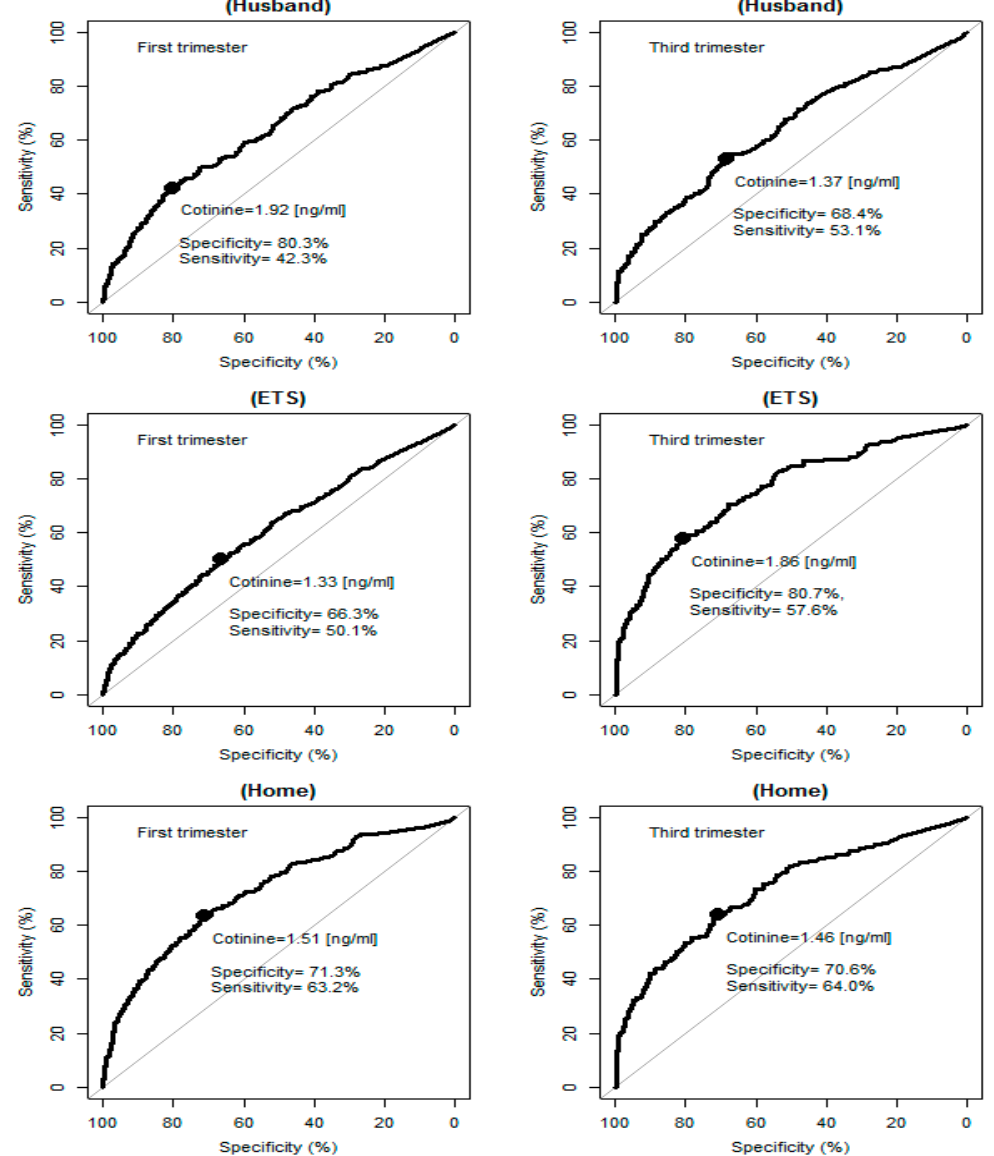
Figure 2. ROC curves for the first and third trimester’s passive smoking by individual sources of exposure. ETS: environmental tobacco smoke. exposure. ETS: environmental tobacco